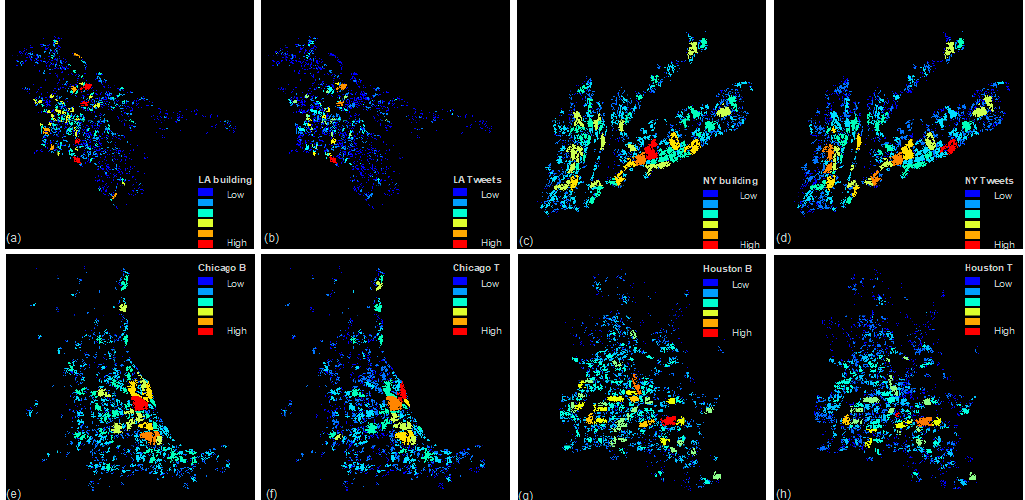
Figure 5. The hierarchical levels of hotspots in the four largest cities: Los Angeles (a, b), New York (c, d), Chicago (e, f) and Houston (g, h) (Note: Red color stands for high point count hierarchy and blue color stands for low point hierarchy; the building counts are a, c, e, g, and tweets counts are shown in b, d, f, and h.)